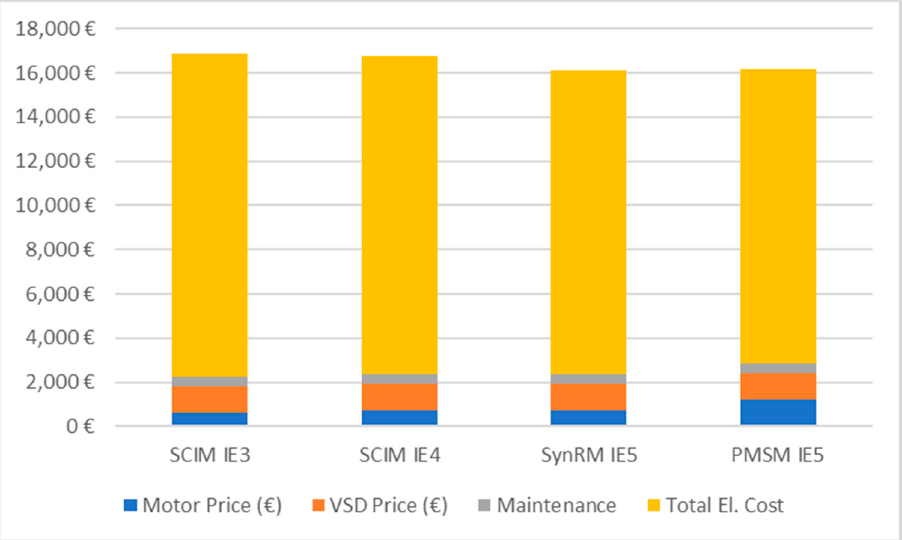
Figure 10. Disaggregated TCO for the different motor technologies and LP1.